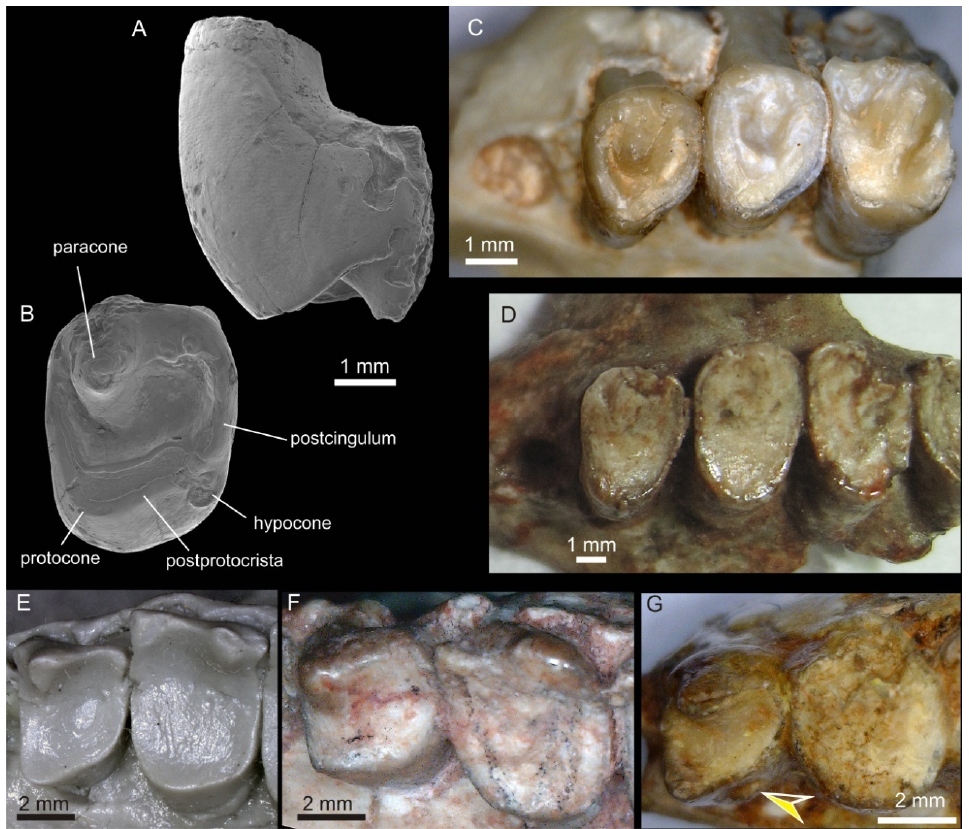
Figure 2. Morphology of ultimate upper premolars in anagalids and large mimotonids. ( A , B ), left P4 (IVPP V26960), new specimen from the middle Eocene, Huheboerhe, Erlian Basin, Nei Mongol, China. ( C ), Gomphos elkema , left maxilla fragment with P3–M1 (IVPP NNG047) from the early Eocene, Nuhetingboerhe, Nei Mongol, China. ( D ), Mimolagus rodens , right P3–M1 (holotype specimen IVPP RV51002.1, mirror view) from the earliest Oligocene of Gansu, China. ( E ), Anagale gobiensis , right P4–M1 (cast of the holotype AMNH 26079, mirror view) from the early Oligocene of the Ulan Gochu Formation, Twin Obo, Nei Mongol, China. ( F ), Anagalopsis kansuensis , right P4–M1 (the holotype, IVPP RV51003, mirror view) from the earliest Oligocene of Gansu, China. ( G ), Hsiuannania tabiensis , right P4–M1 (IVPP V4274, in mirror view; a small hypocone at P4 is marked with yellow arrow) from the middle Paleocene of Anhui, China. (Photographs by ŁFF).